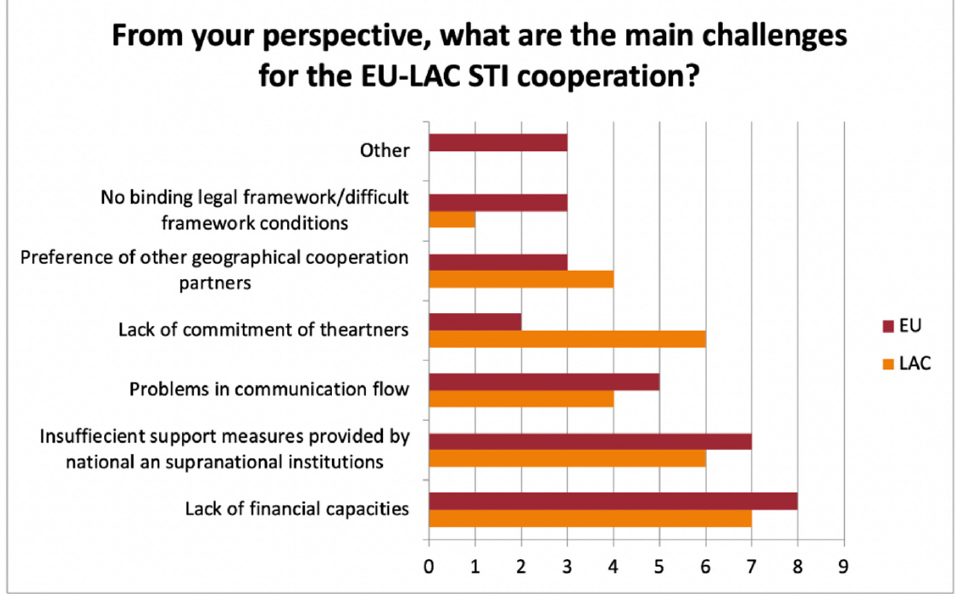
Figure 4. Main challenges for EU–LAC STI cooperation.